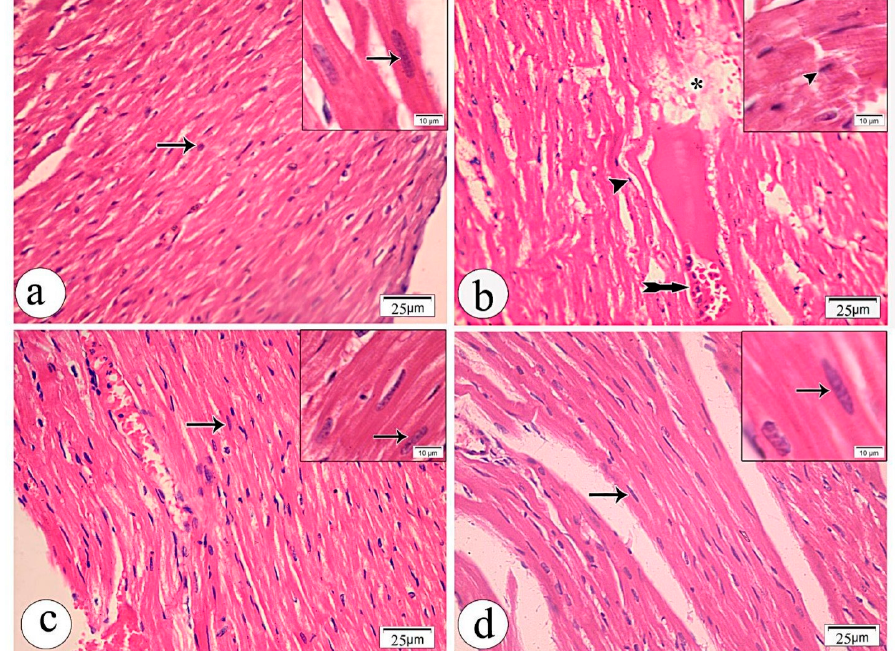
Figure 3. Photomicrographs of heart sections stained by hematoxylin and eosin: ( a ) control group showing the normal histological structure of cardiac myocytes that appeared arranged in a linear array that branched and anastomosed with acidophilic sarcoplasm and oval, centrally located nuclei (arrow); ( b ) gentamycin-treated group showing that most of the cardiac muscle fibers were disorganized and lost the normal striations, while nuclei of the cardiomyocytes showed deformation in sizes and shapes, and others appeared pyknotic (Head arrow), in addition to cytoplasmic loss and fragmentation of cardiac muscle (star) and interstitial hemorrhage (tailed arrow); ( c ) gentamycin- and PUFA-treated group showing regular arrangement of the cardiac muscle fibers with oval, centrally located vesicular nucleus (arrow); ( d ) gentamycin- and MSC-treated group showing regularly arranged cardiac myofibers with oval, rounded nuclei (arrow). Note that inset images of higher magnification were added in all panels photos to show the